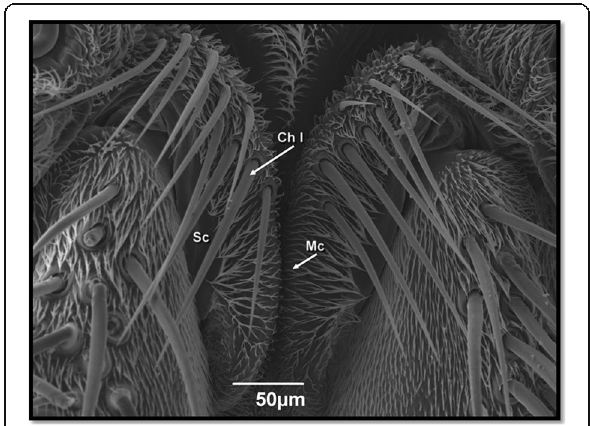
Fig. 8 Scanning electron micrographs showing the cuticular surface of scape of male of Mesembrinella semihyalina (× 350). Sc = Scape; ChI = chaetic sensilla; Mc = microtrichia